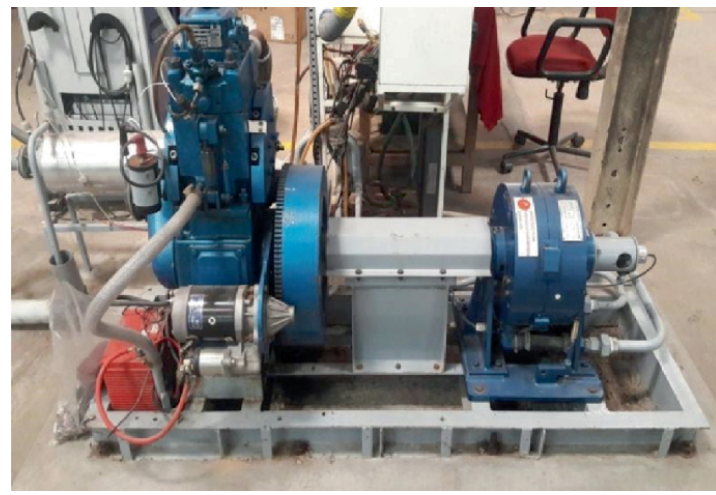
Figure 4. Experimental setups for engine performance on a 4-stroke engine.